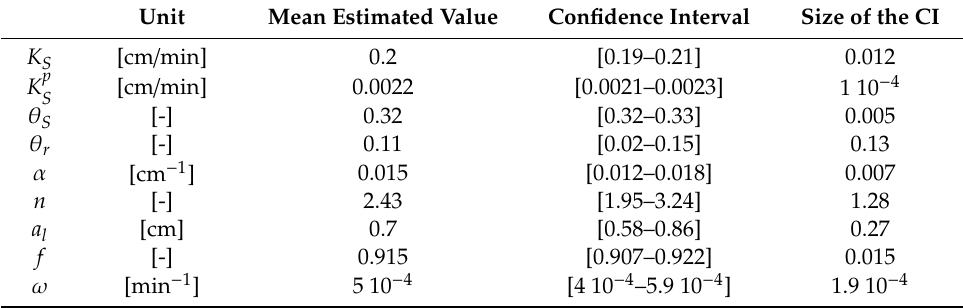
Table 3. Estimated mean values, confidence intervals (CIs), and size of the posterior CIs for the mobile–immobile